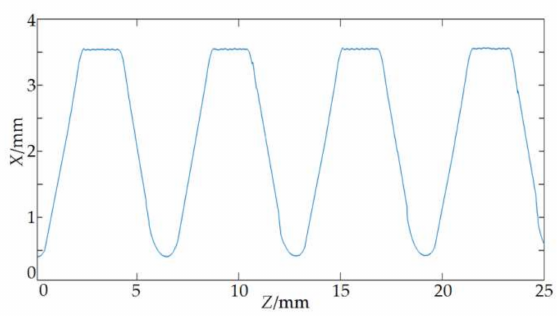
Figure 15. Contour data after compensation and denoising.